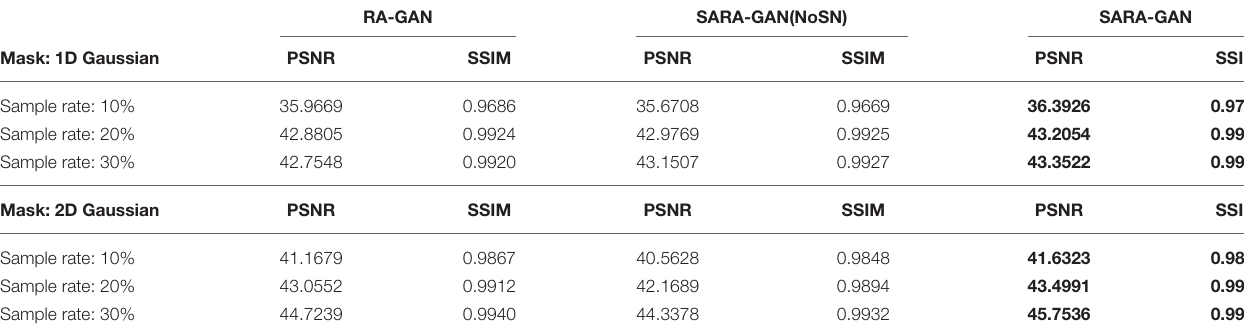
TABLE 4 | The influence of self-attention mechanism and SN on PSNR and SSIM of the reconstructed image. RA-GAN SARA-GAN(NoSN)